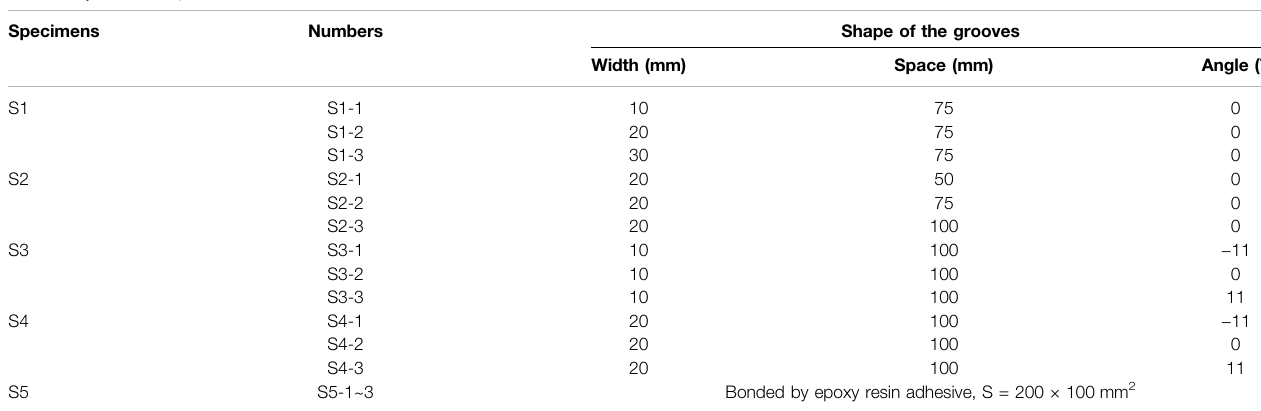
TABLE 1 | Details of